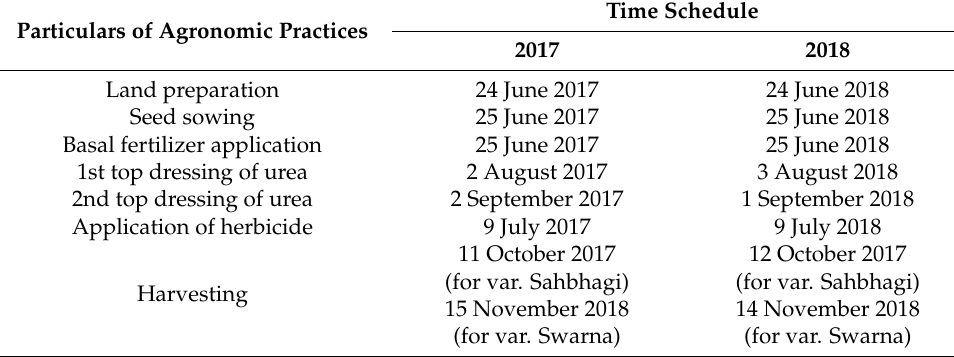
Table 1. Details of the calendar of agronomic practices during